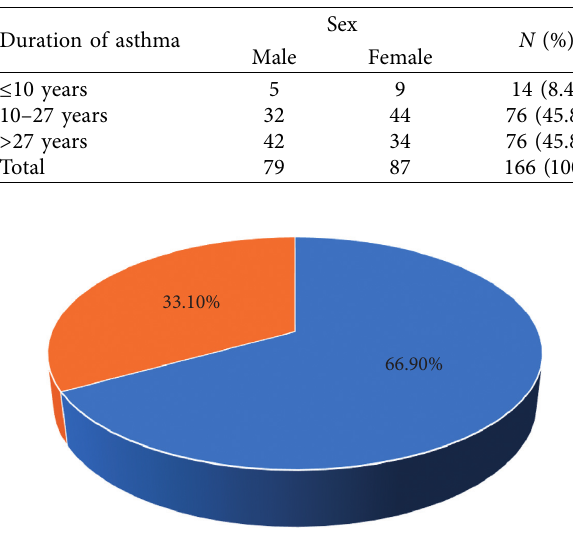
Table 2: Duration of asthma of patients at DMCSH, 2020.